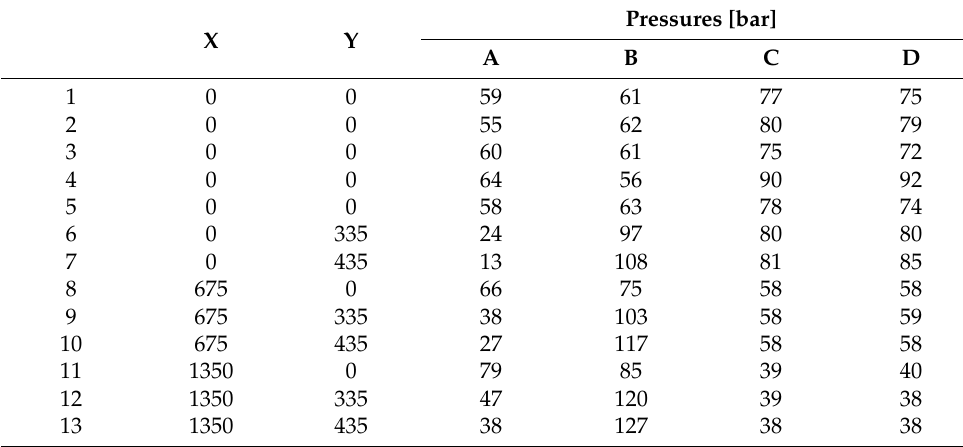
Table 2. Experiment inputs (X and Y) and pressures obtained from